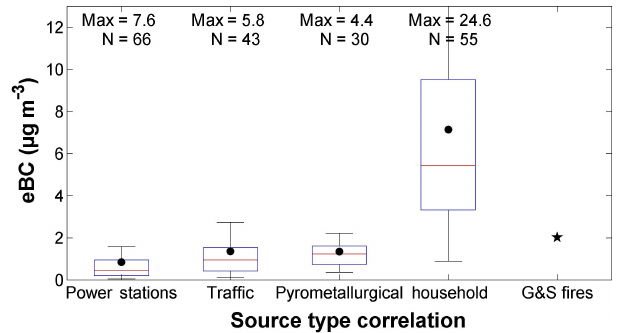
Figure 14. (cid:49) eBC measured during plumes when eBC increases originated from coal-fired power stations, traffic, pyrometallurgical smelters and household combustion as measured at Elandsfontein. The overall mean baseline increase due to savannah and grassland fires (G&S fires) in September is also indicated. These data were normalised to variations in boundary layer at Elandsfontein (Ko- rhonen et al.,